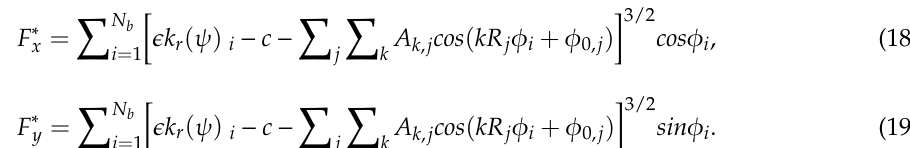
Figure 6. Influence of different runouts on load distributions: ( a ) normal, ( b ) inner race runout, ( c ) ball runout, and ( d ) non-uniform cage.